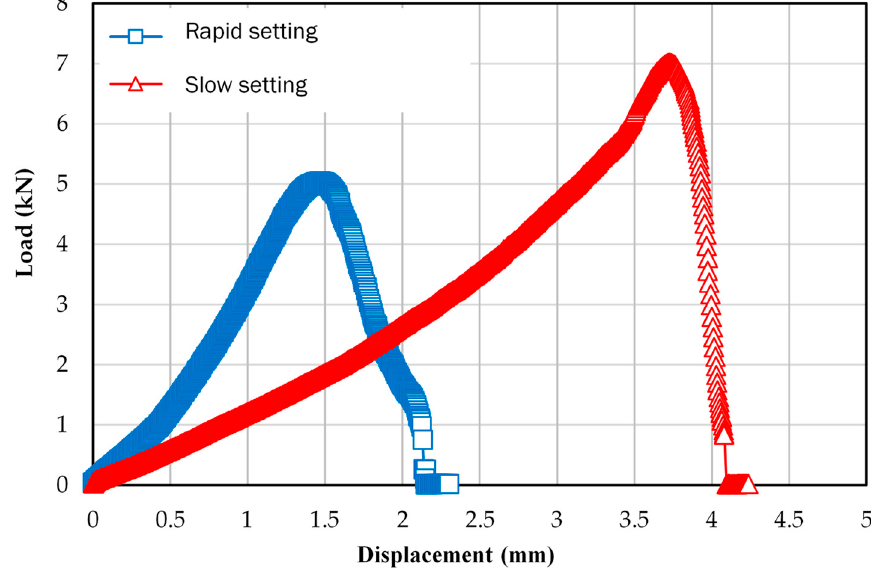
Figure 4. Representative load–displacement curves for all Laboratorio de Caminos de Barcelona shear tests.